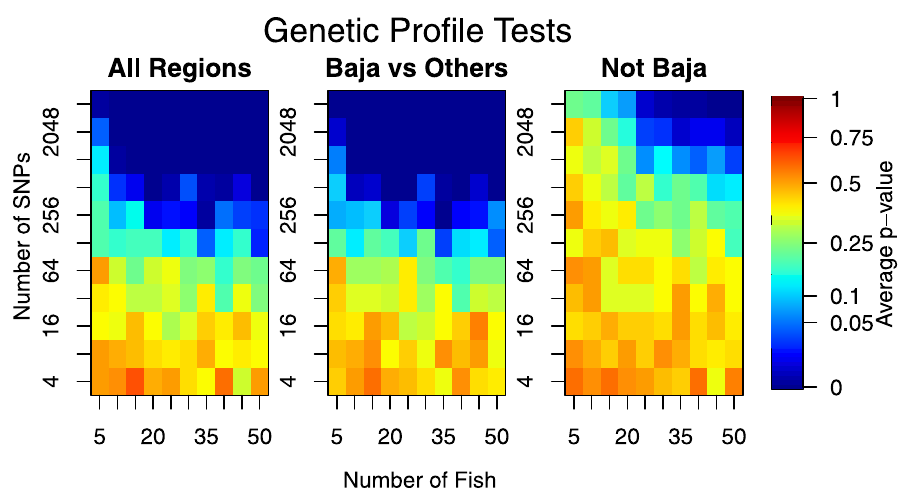
Fig 3. Results from genetic profile (hypothesis) testing experiment. Left panel is for the hypothesis test of no differences between all 4 geographical regions. Central panel is for the test of no differences between the Baja California region and the three remaining regions (combined). Right panel is for a test of no differences amongst the three West Pacific regions (Baja California removed). Lower values (cooler colours) reflect lower p-values and hence, on average, a higher chance of rejecting the null hypothesis (i.e., of detecting differences).